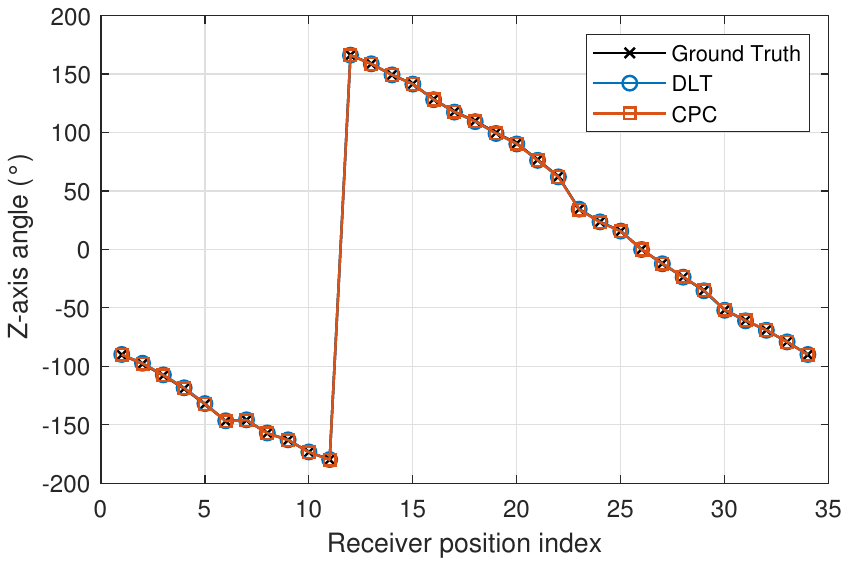
Figure 15. Z-axis angle using DLT and